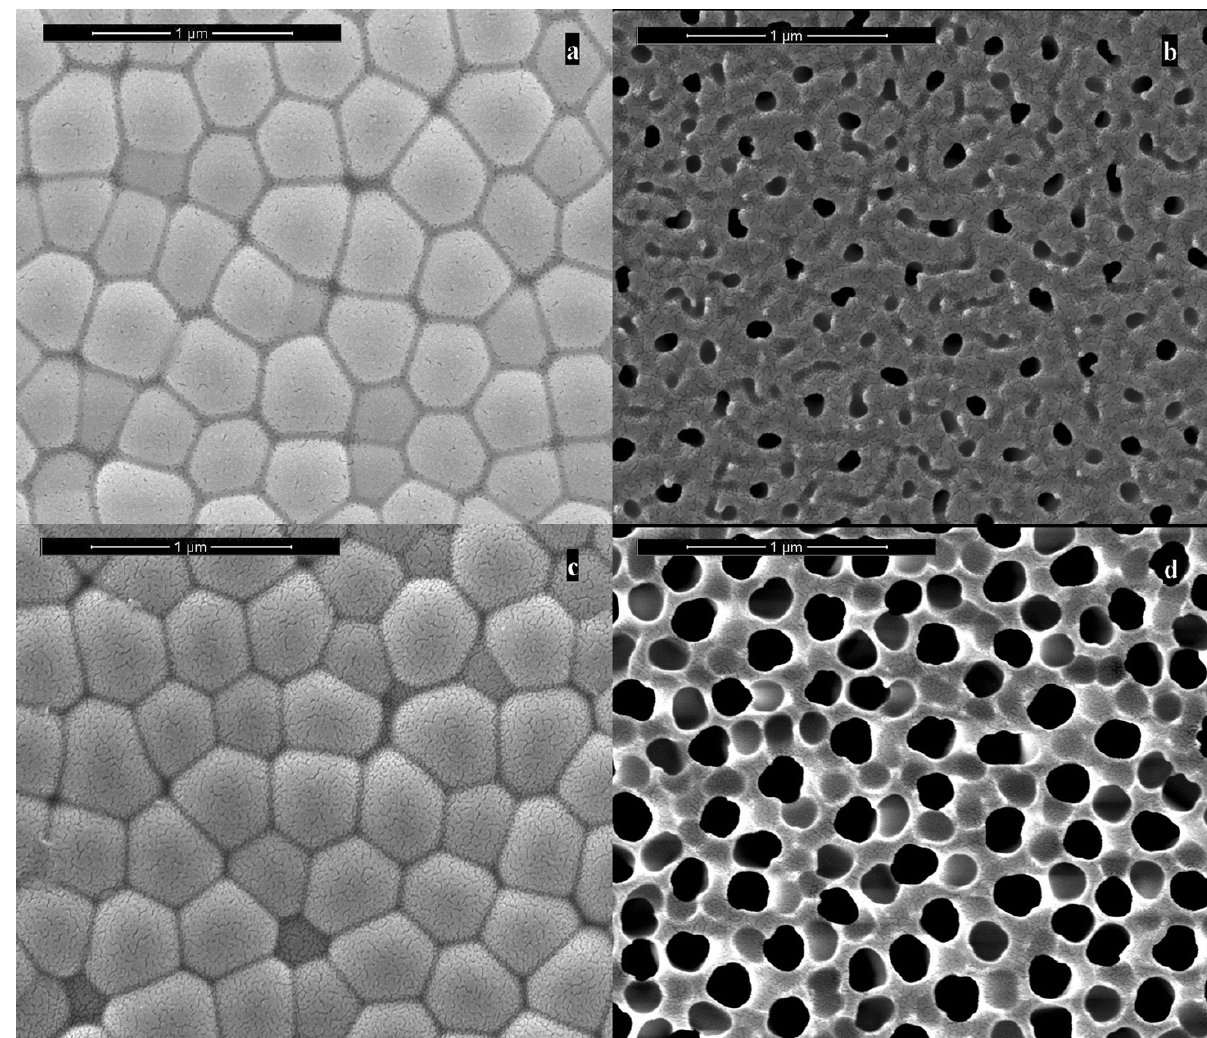
Figure 9. Top views of PAA formed in 0.4 M H 3 PO 4 at 160 V and 0 °C: ( a , b ) inner, and outer surface at 20 C cm − 2 , respectively; ( c , d ) inner, and outer surface at 160 C cm − 2 , respectively.